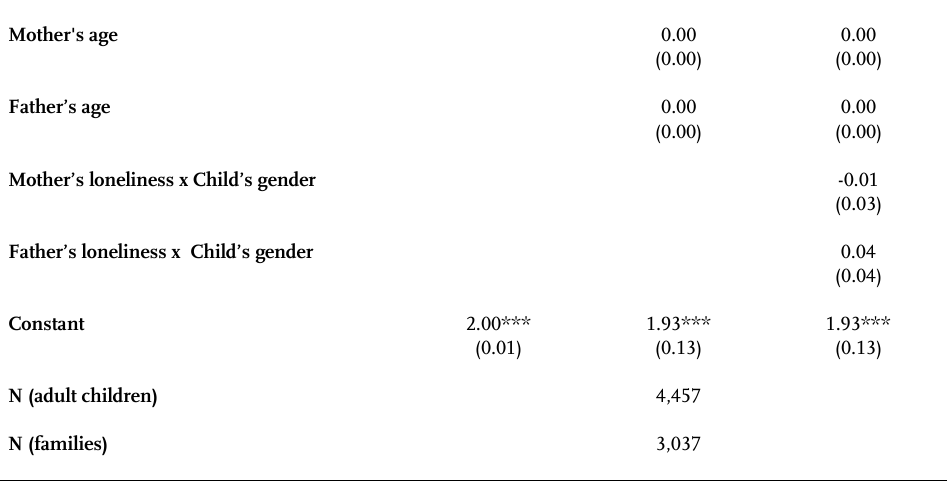
Table 3 : Multilevel regression: The relationship between loneliness in parents and their adult children (unstandardized coefficients)